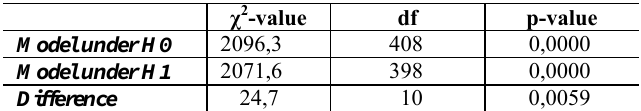
Table 8: Factor co-variances cross-validation: Chi- square difference test